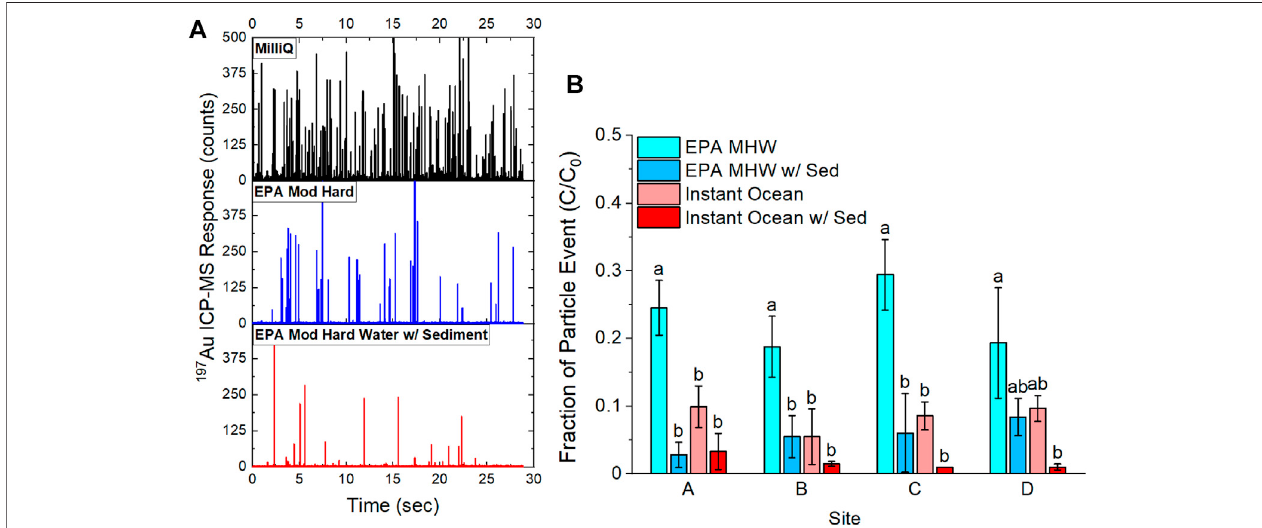
FIGURE 6 | Comparison of Au-Tracer@PS particle events before and after equilibration with sediment slurry. (A) Raw date time traces showing Au-Tracer@PS particles in suspension with MilliQ water, EPA moderately hard water, and EPA moderately hard water with sediment. (B) Comparison of particle events normalized to particle events in MilliQ water (C 0 ) in a freshwater matrix (EPA MHW) and a saltwater matrix (30 g L − 1 Instant Ocean) with and without the addition of sediment ( n (cid:1) 3).